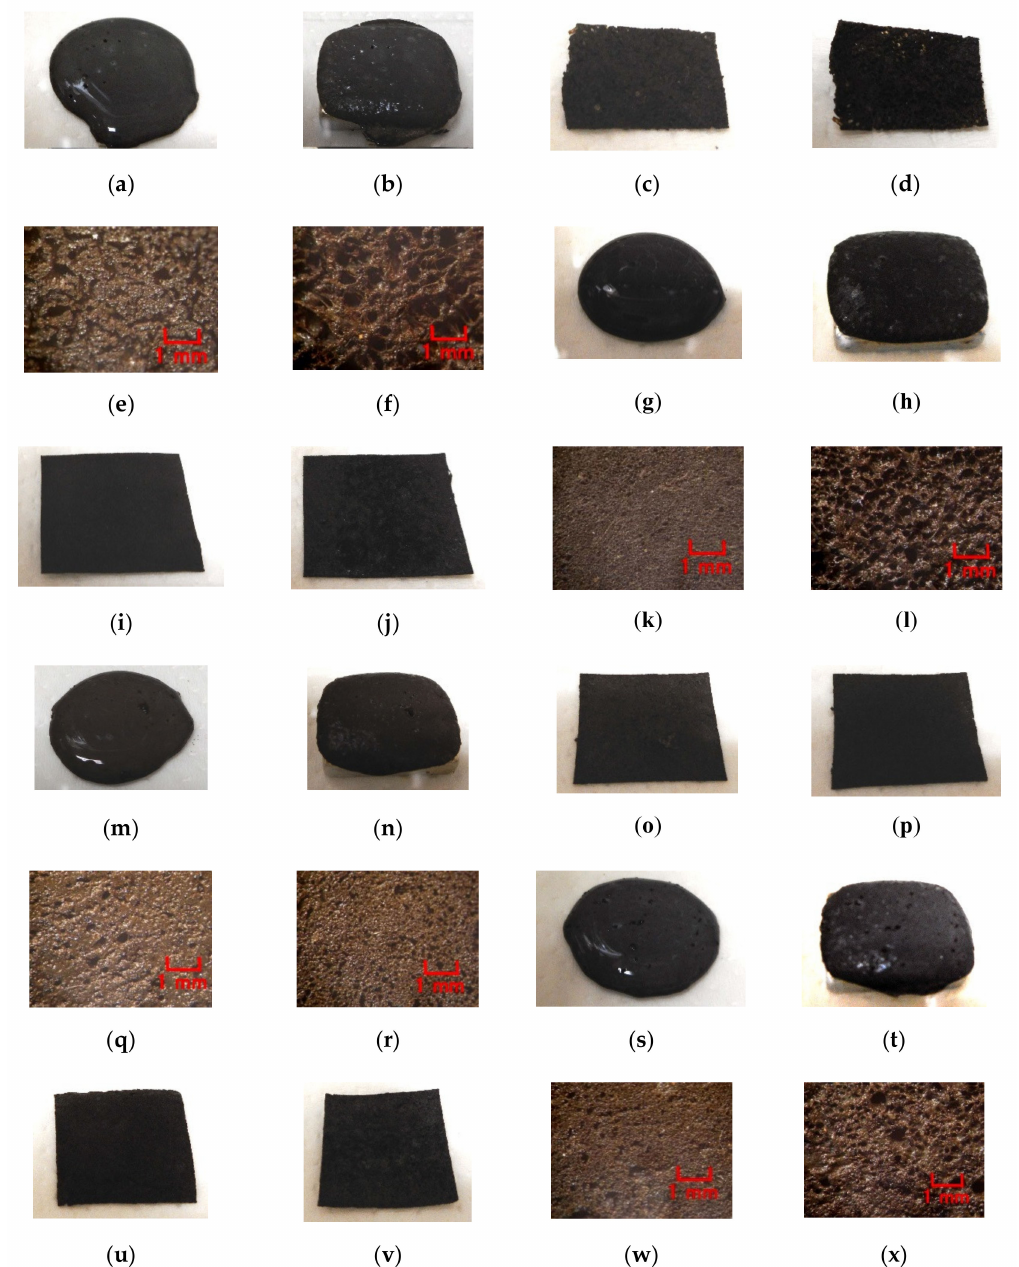
Figure 11. Images of liquid before electrolytic polymerization and electrolytically polymerized rubber mixed with KF96 and water-insoluble MF: ( a – f ) MSGS60; ( g – l ) A500; ( m – r ) HC50; ( s – x ) DS50; ( a , g , m , s ) liquid before electrolytic polymerization without magnetic field; ( b , h , n , t ) liquid before electrolytic polymerization under magnetic field; ( c , i , o , u ) panoramic image of electrolytically polymerized rubber facing anode; ( d , j , p , v ) panoramic image of electrolytically polymerized rubber facing cathode; ( e , k , q , w ) microscopic image of electrolytically polymerized rubber facing anode by optical microscope; ( f , l , r , x ) microscopic image of electrolytically polymerized rubber facing cathode by optical